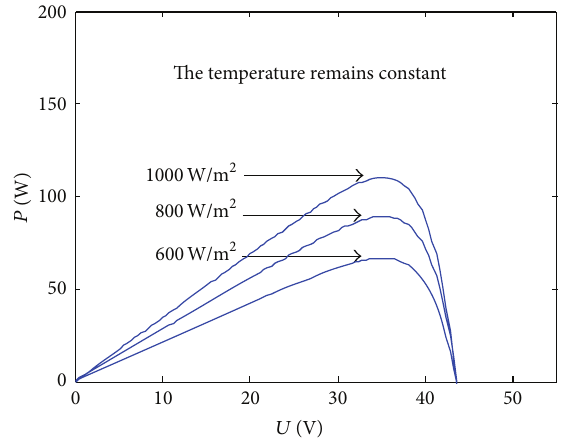
Figure 3: 𝑃 - 𝑈 characteristic curves of PV cell with different solar irradiation values.